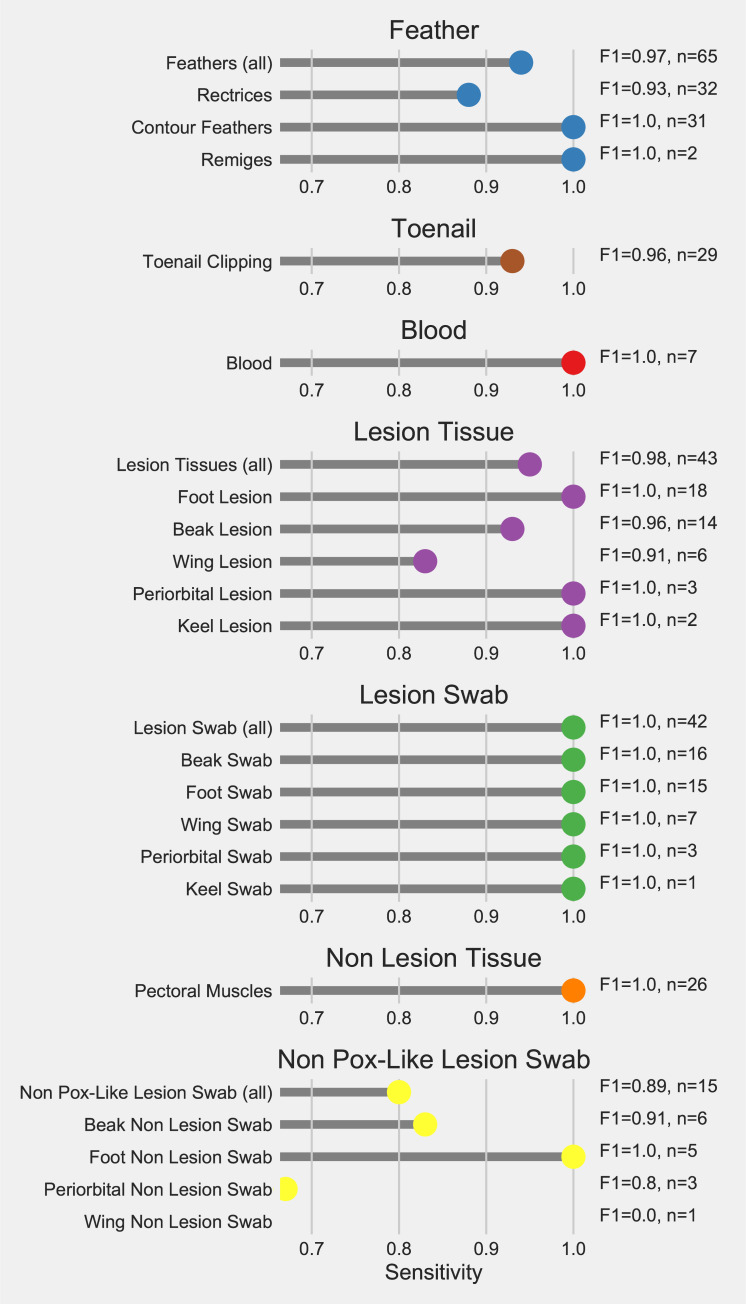
Assessment of performance of a real-time PCR assay for detecting Avipoxvirus in samples from Anna’s (n = 26) and Selasphorus spp. (n = 1) Hummingbirds in comparison to true infection status.Dots represent the sensitivity of the real-time PCR. F1 score statistics and the number of samples for each sample type are reported next to each sample type. Positive predictive values (PPV) for all sample types were calculated to be 1, except for the pox-like lesion swab of the wing (PPV = 0).